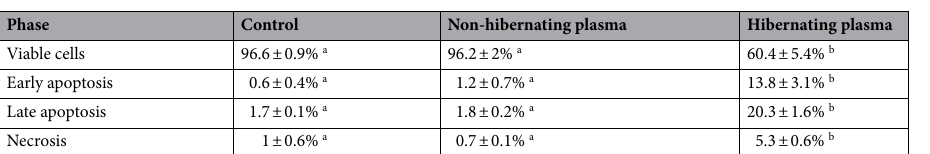
Table 1. The mean percentage of viable cells, early apoptotic cells, late apoptotic cells, and necrotic cells after 24 h incubation with standard culture media (control), non-hibernating plasma (16 mg/ml), and hibernating plasma (16 mg/ml). Values represent mean ± standard deviation of three different experiments. In each row, levels are not connected by the same letters are significantly different ( P <